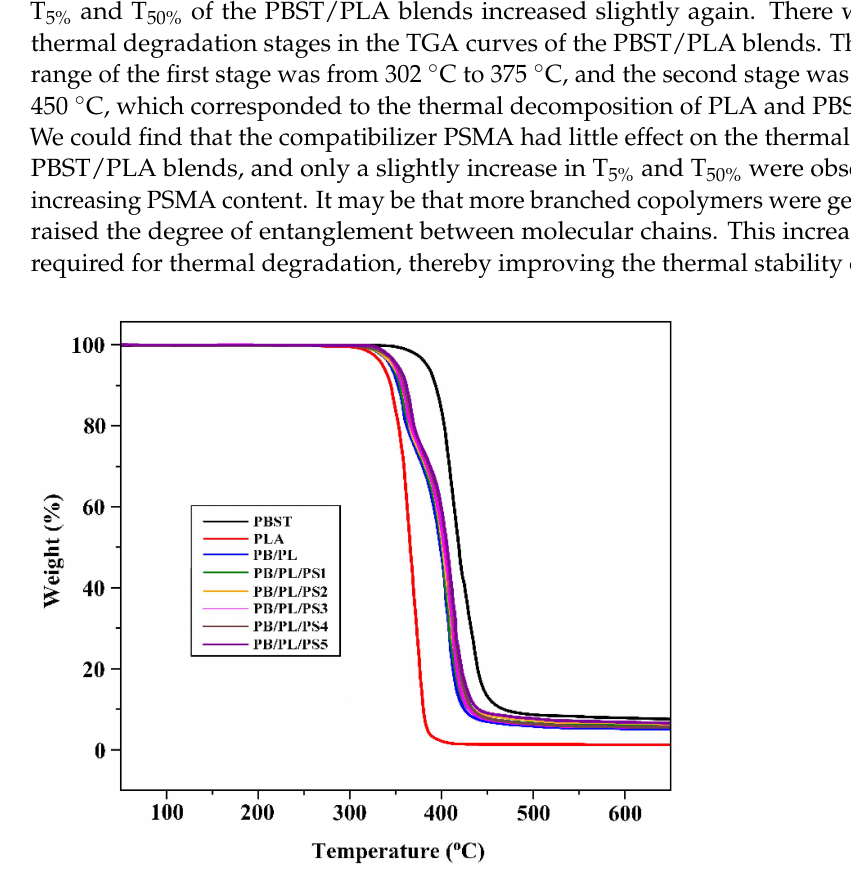
Figure 4. TGA curves of neat PBST, PLA, and PBST/PLA blends with various amounts of PSMA. Table 3. TGA data for neat PBST, PLA, and PBST/PLA blends.